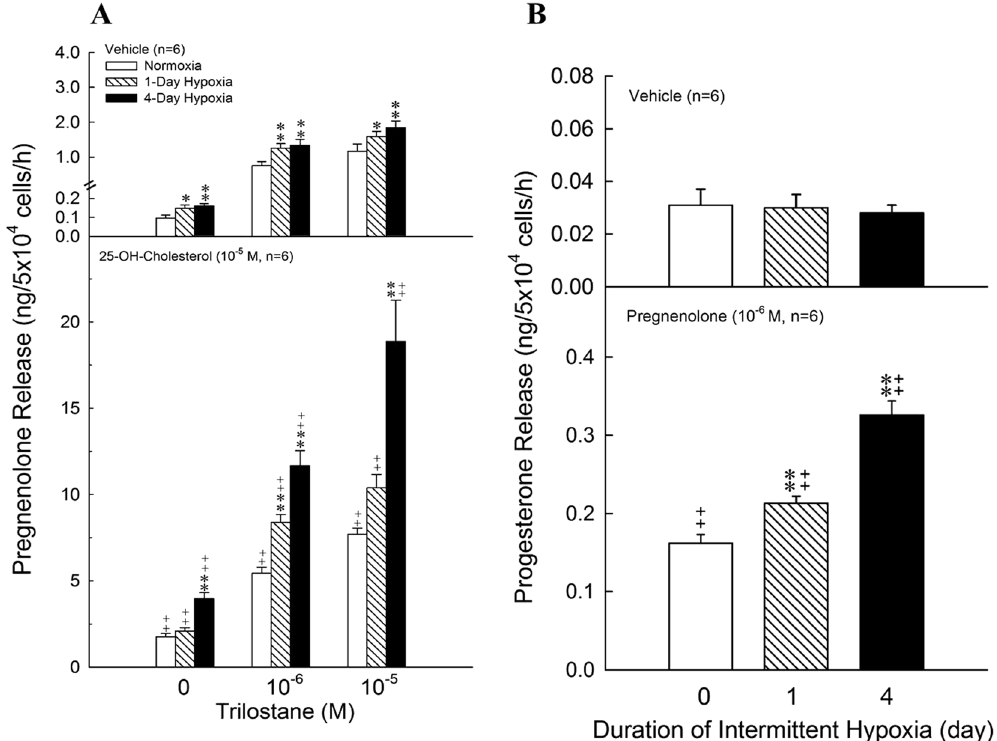
Figure 4. Effects of hypoxia on the activity of P450scc and 11 β -HSD in ZFR cells. ( A ) * P < 0.05, ** P < 0.01 compared to normoxia (control) group. ++ P < 0.01 compared to trilostane = 0, 10 − 6 or‘ 10 − 5 M. Each value represents the mean ± SEM. ( B ) ** P < 0.01 compared to normoxia (control) group. ++ P < 0.01 compared to control group. Each value represents the mean ±